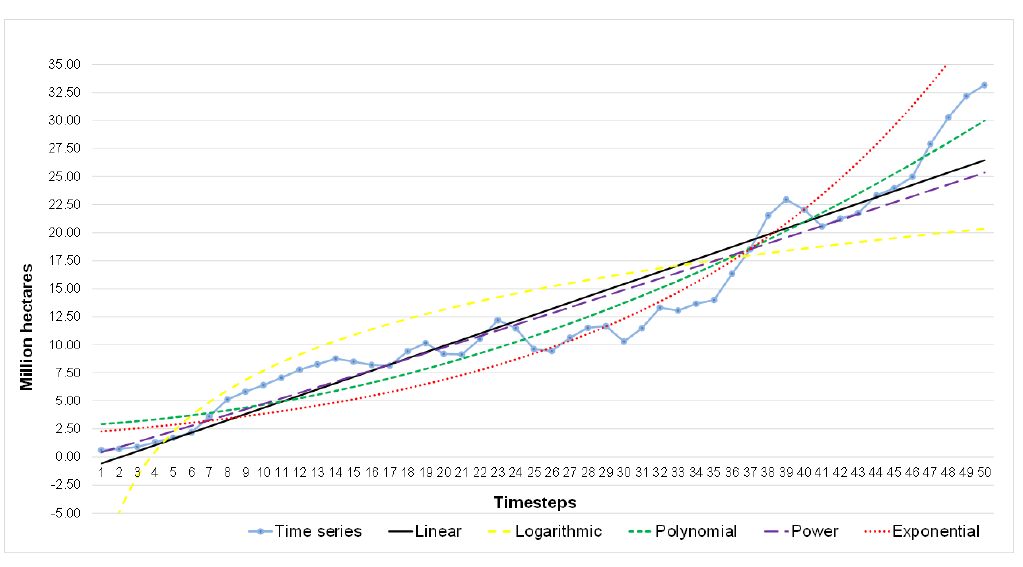
Figure 4. Original time series for harvested area.